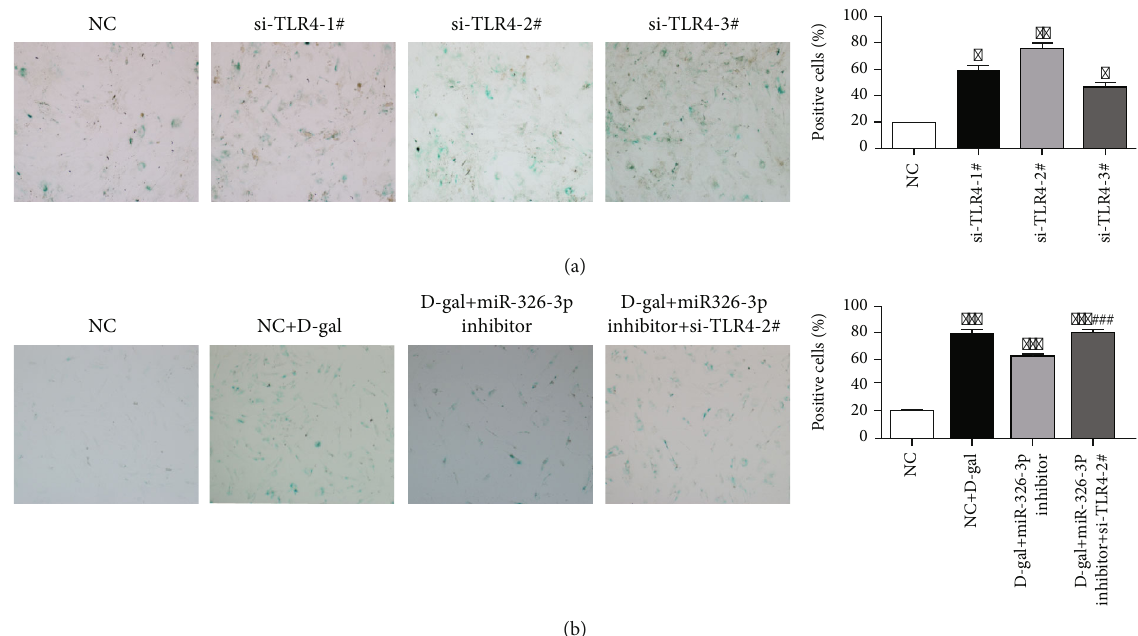
Figure 5: TLR4 modulated skin fi broblasts senescence. (a) SA- β -gal staining analysis of skin fi broblasts after transfected with siRNA-TLR4 (10 × ). (b) SA- β -gal assay of skin fi broblasts after cotransfected with siRNA-TLR4 and miR-326-3p inhibitor (10 × ). ∗ p < 0 : 05 vs. NC, ∗∗ p < 0 : 01 vs. NC, ∗∗∗ p < 0 : 001 vs. NC. ### p < 0 : 001 vs. D-gal+miR-326-3p